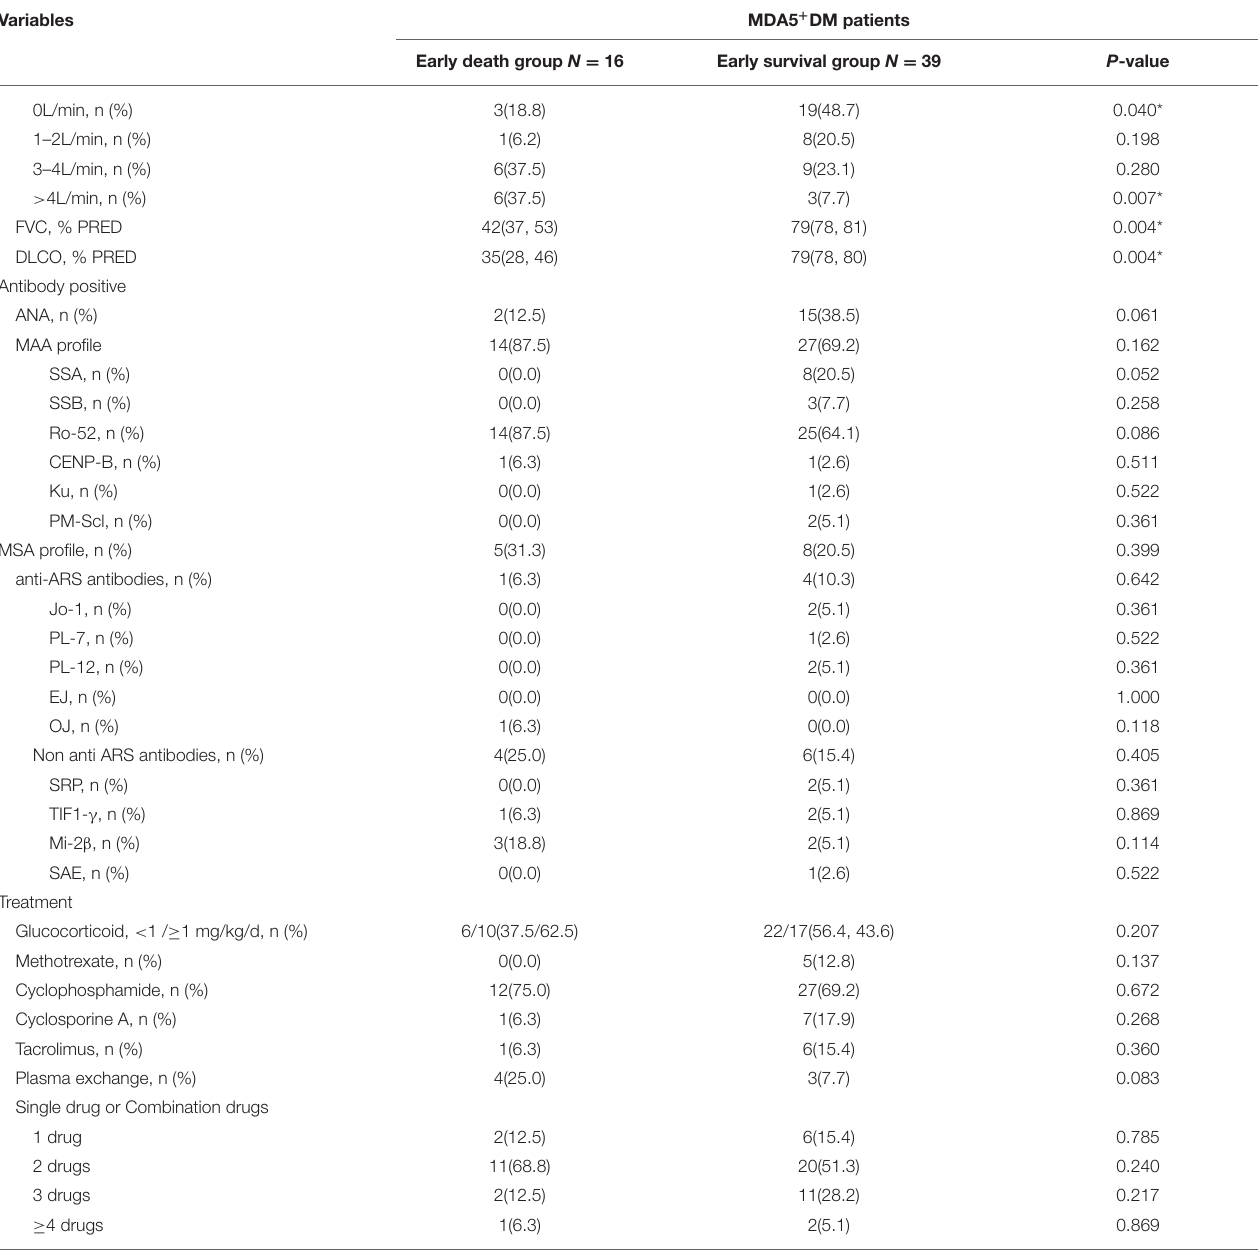
higher ELVAR group (ELVAR ≥ 0.835). The comparison revealed that the rates of mortality within 3 months in the lower and higher ELVAR groups were 54.2 vs. 9.7%, respectively, whereas 12-month mortality rates were 54.2 vs. 12.9%, respectively ( Figure 5D ), which indicated that the ELVAR value was more predictive of early mortality within 3 months. The differences